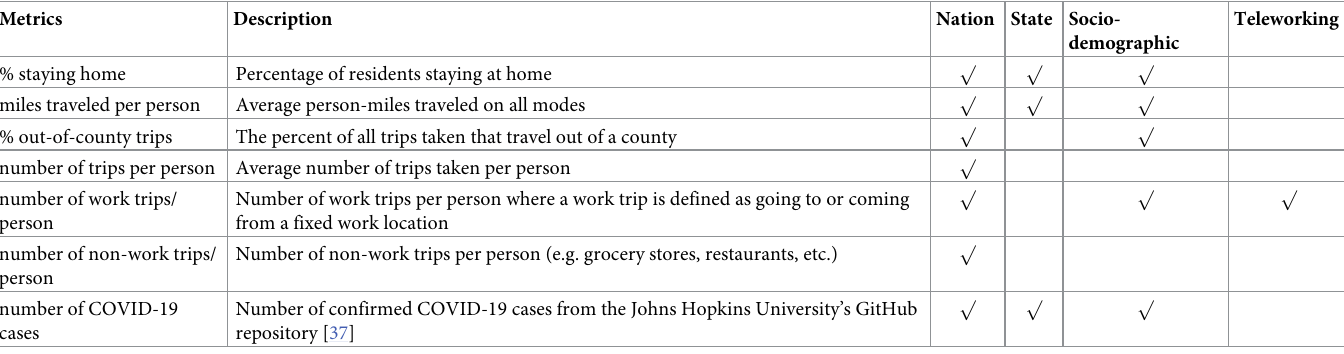
Table 1. A Summary of metrics adapted from the COVID-19 Impact Analysis Platform.